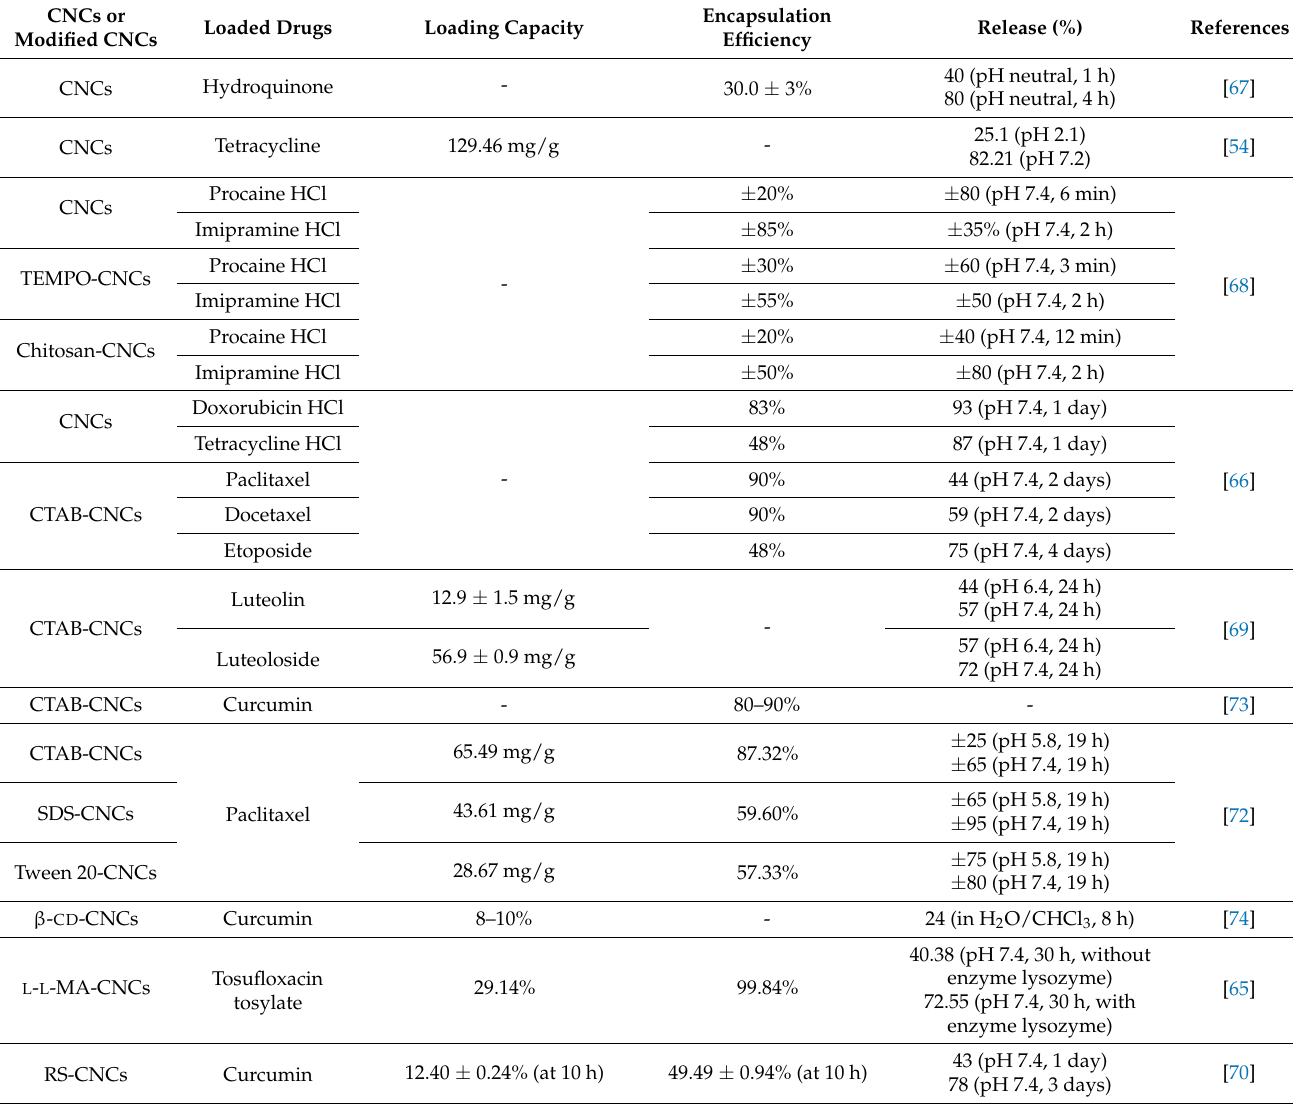
Table 5. The capability of CNCs as a drug carrier for several types of